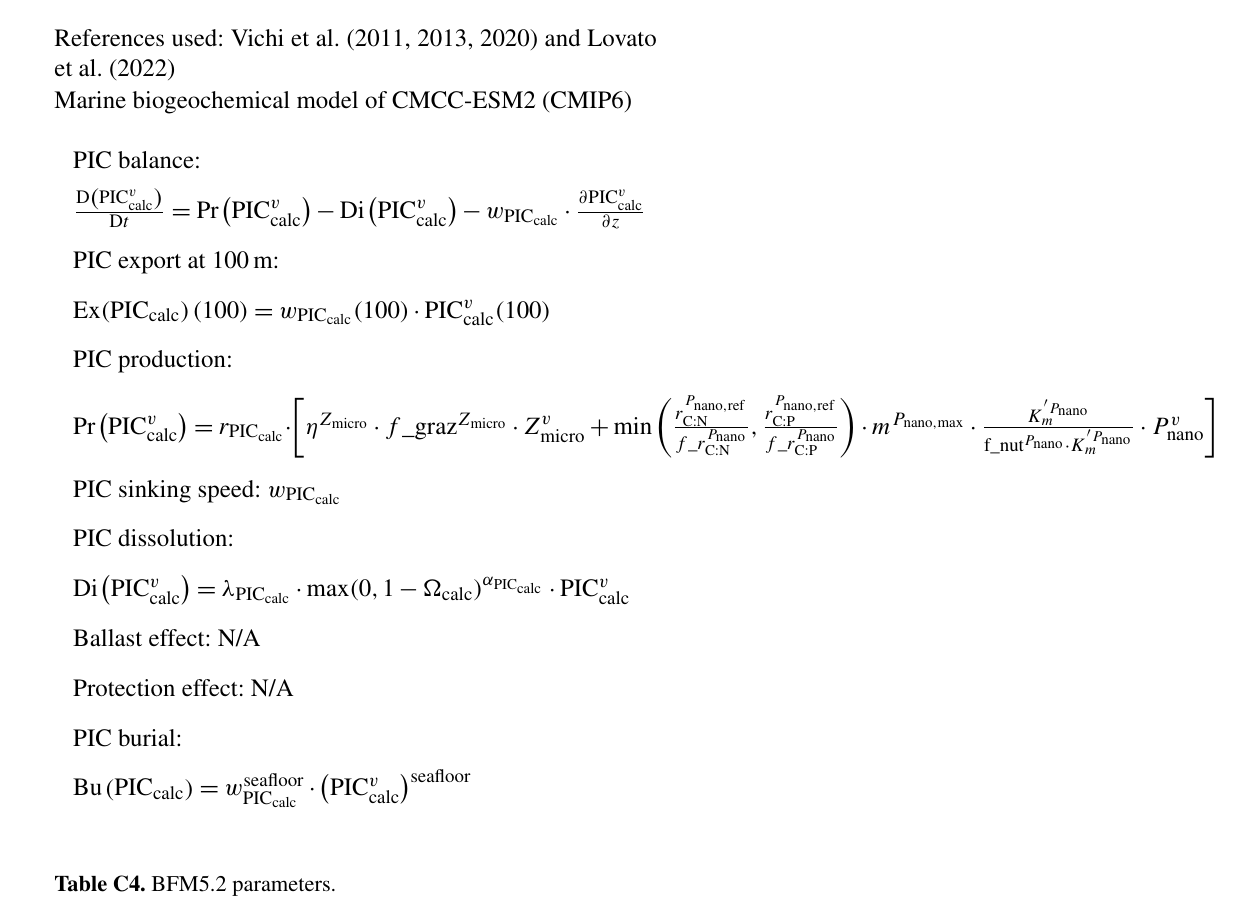
Table C4. BFM5.2 parameters.